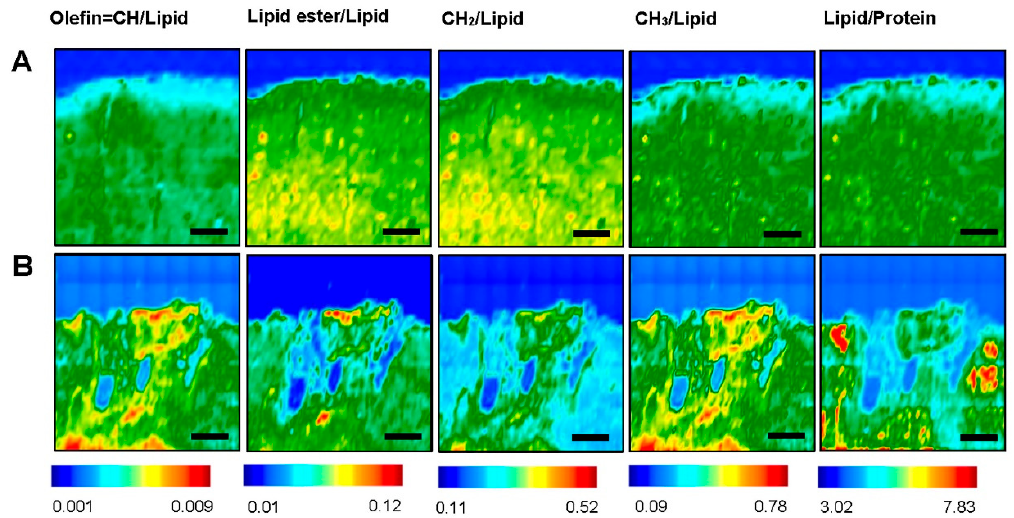
Figure 3. Fourier Transform Infrared (FTIR) images of different lipid components—Olefin=CH/Lipid, Lipid ester/Lipid, CH 2 /Lipid, CH 3 /Lipid and Lipid/Protein at ( A ) Contra-lesional and ( B ) Ipsi-lesional of nine weeks post stroke brain tissue. The color bars showing the intensity of the biochemical components—red as maximum and blue as minimum. Scale bar = 100 µm.